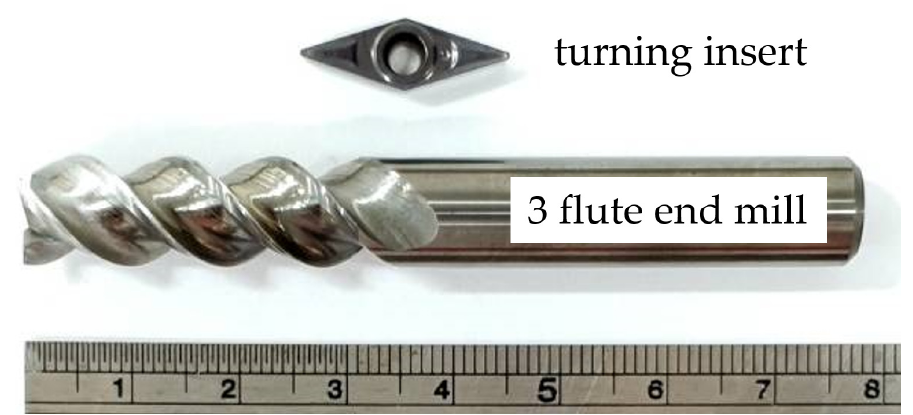
Figure 3. Cutting tools of turning and milling.